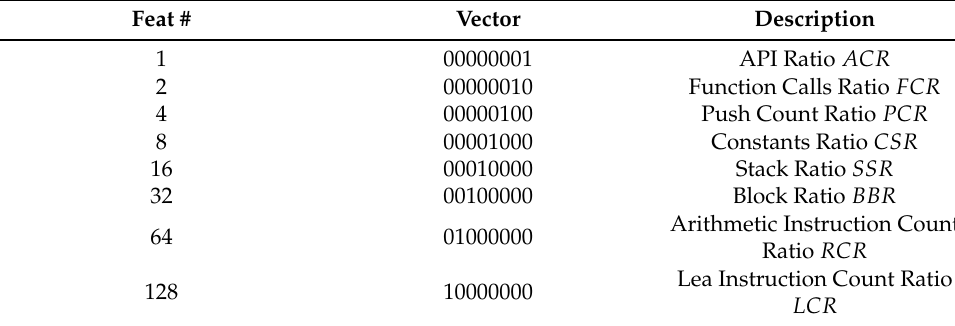
Table 5. Identification of Feature Combination